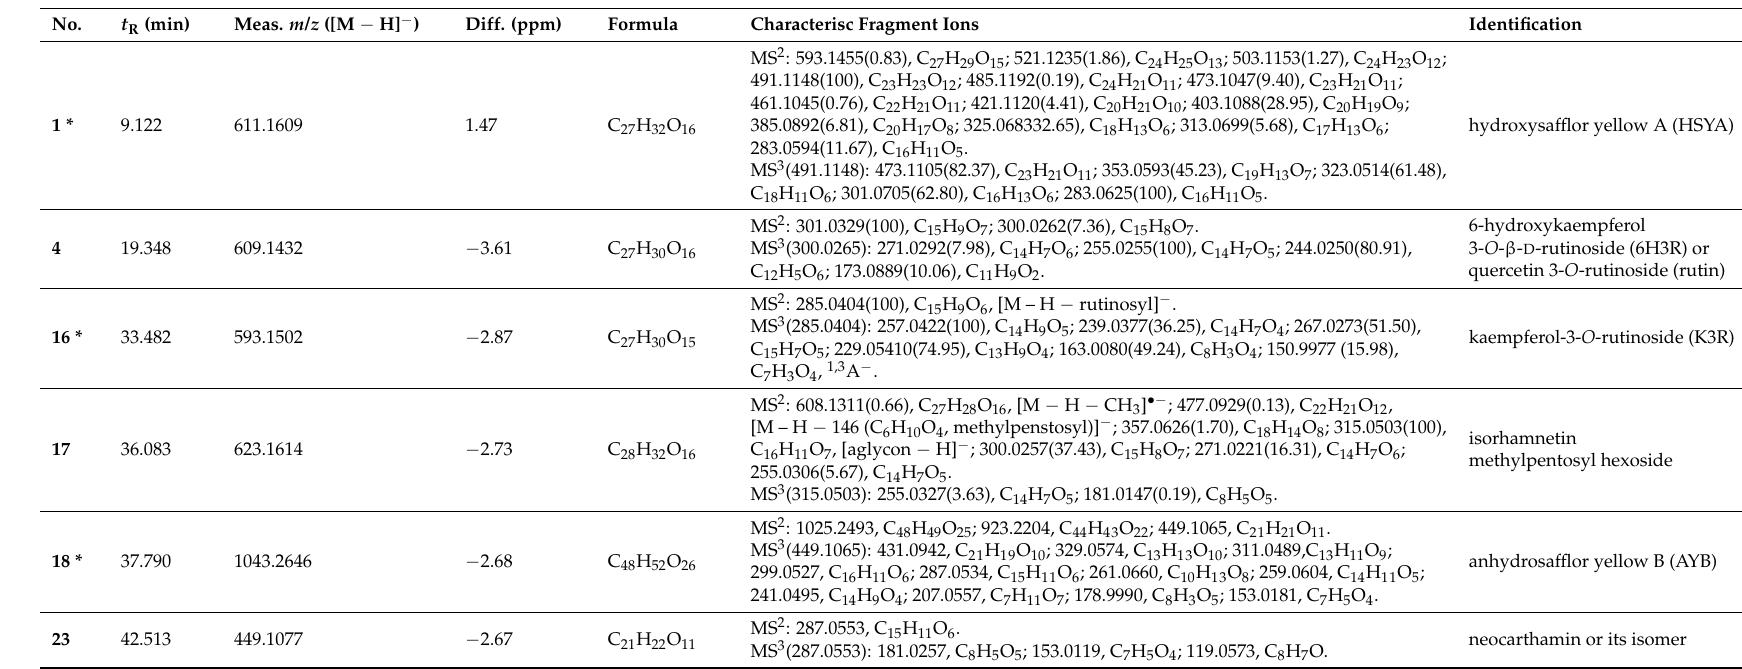
Table 1. Representative compounds identified in the SAFE by HPLC-ESI-IT-TOF-MS n